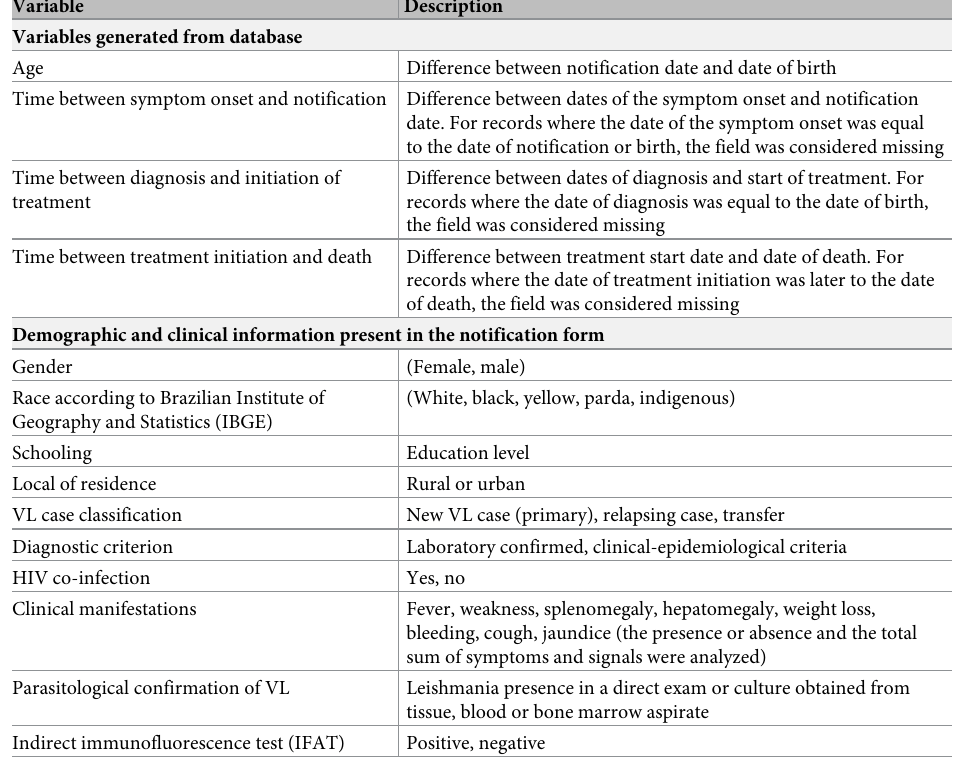
Table 1. Potential risk factors for case-fatality from VL explored at individual level (variables extracted from the VL case notification